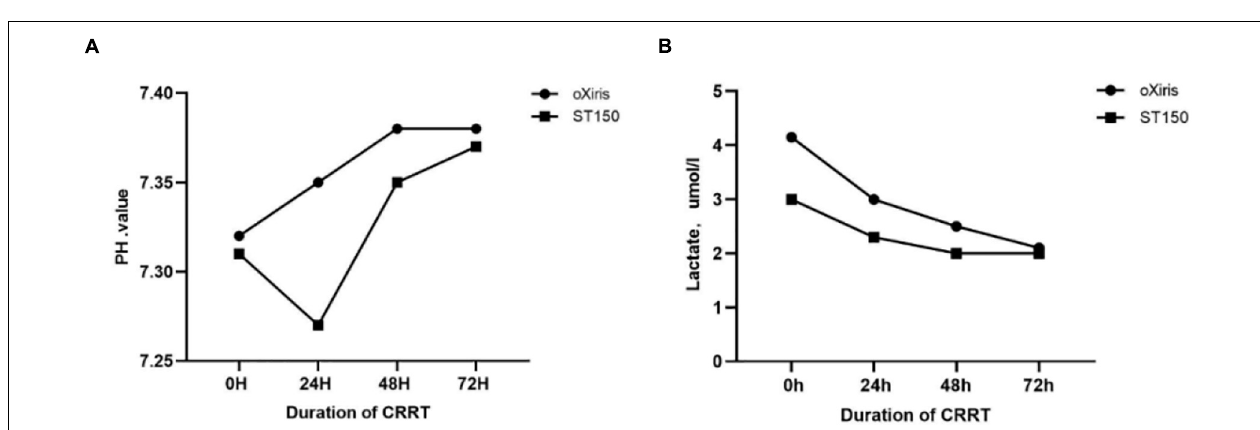
FIGURE 5 | The homeostasis indicators during filter treatment period (0–72 h) in the oXiris filter and ST15 groups. (A) Hydrogen ion concentration (pH), (B)